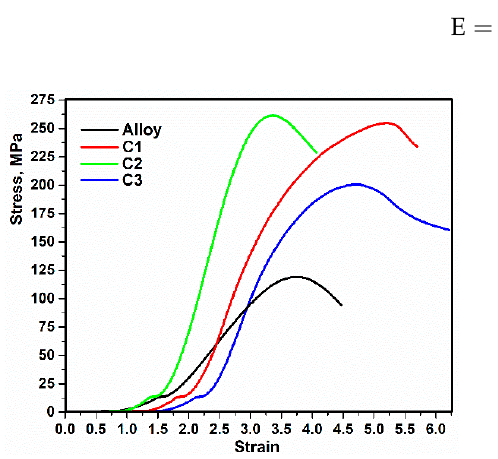
Figure 9. Strain–stress curves of alloy and composites.